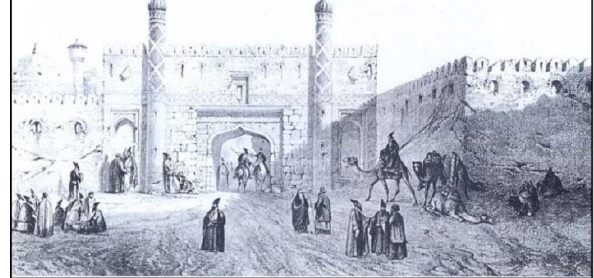
Figure 18. Fortification of Tabriz Reconstructed after Destructive Earthquake in 1780 (By Eugène Flandin) (UNESCO,